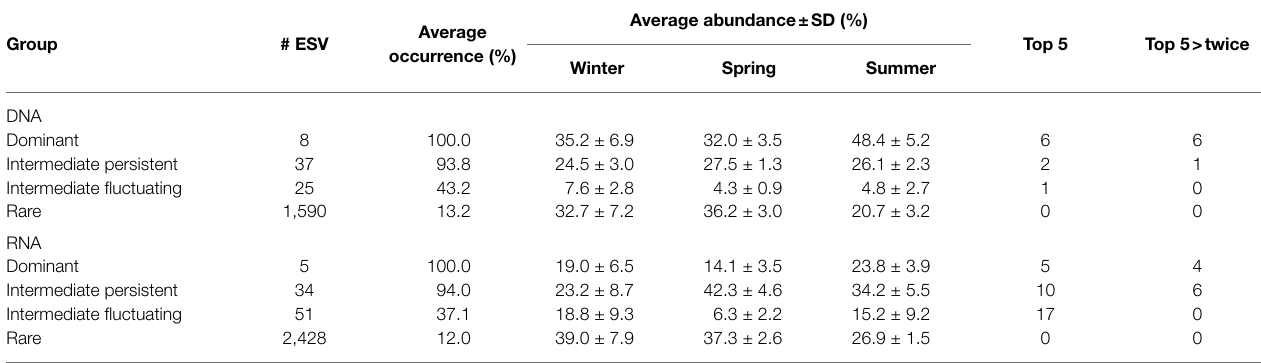
TABLE 1 | Overview of the occurrence and abundance of ESVs grouped into four categories: dominant: ≥ 1% relative abundance in 75% of the samples, rare: always <1% relative abundance, intermediate persistent: present in ≥ 75% of the samples, intermediate fluctuating <75% of the samples. Average abundance ± SD (%) Average Group # ESV Top 5 Top 5 > twice occurrence (%) Winter Spring Summer DNA